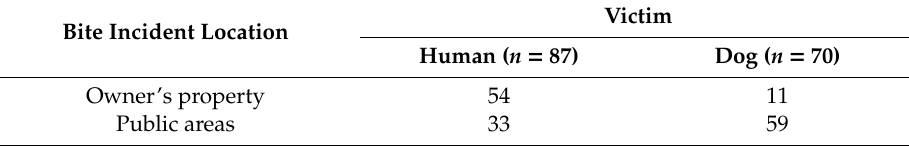
Table 22. Comparisons between bite incident locations and type of victim.